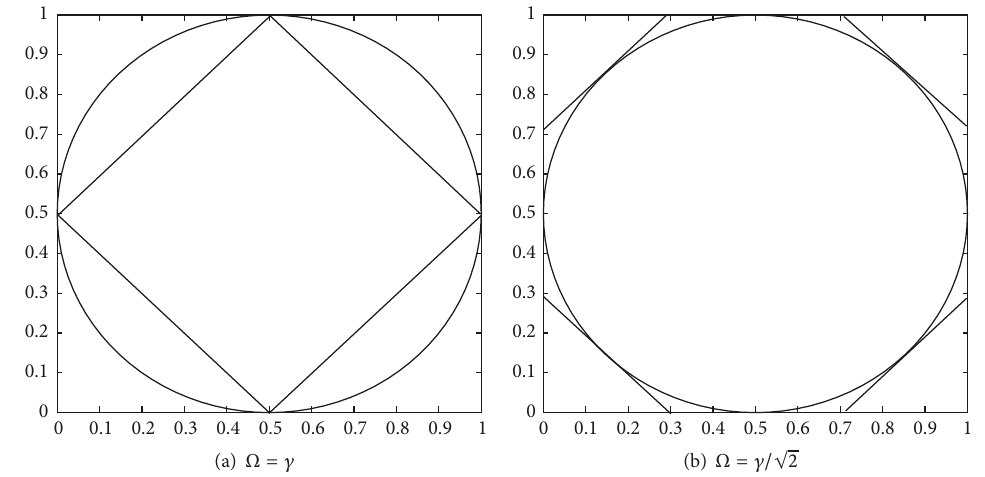
Figure 2: The relationship between ball and budget perturbation set.